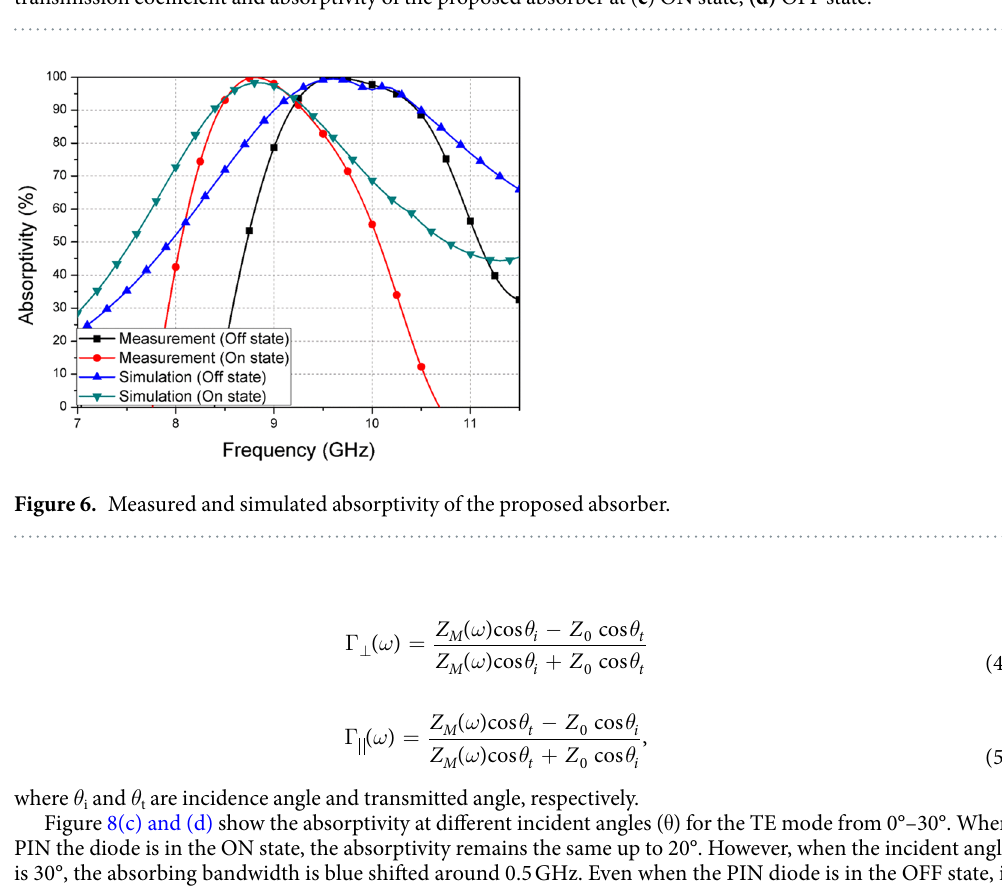
Figure 5. Normalized complex intrinsic impedance at ( a ) ON state, (b) OFF state, the simulated reflection and transmission coefficient and absorptivity of the proposed absorber at ( c ) ON state, (d) OFF state.